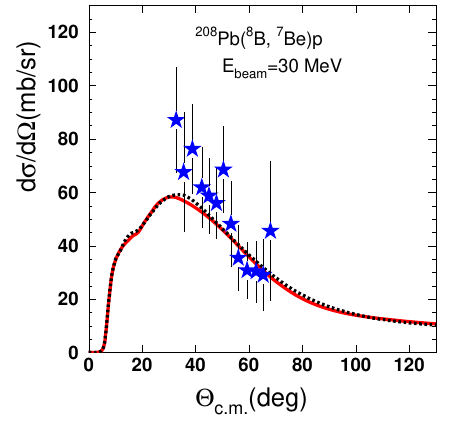
Figure 2. Angular distribution of the observed 8 B → 7 Be + p breakup yield on a lead target at a 8 B incident energy of ≈ 30 MeV (middle of the target). The solid and dashed curves de- note the summed breakup angular distributions from the full (Coulomb plus nuclear potentials) and Coulomb potentials only CDCC calculations, respectively. Figure taken from Ref. [14].